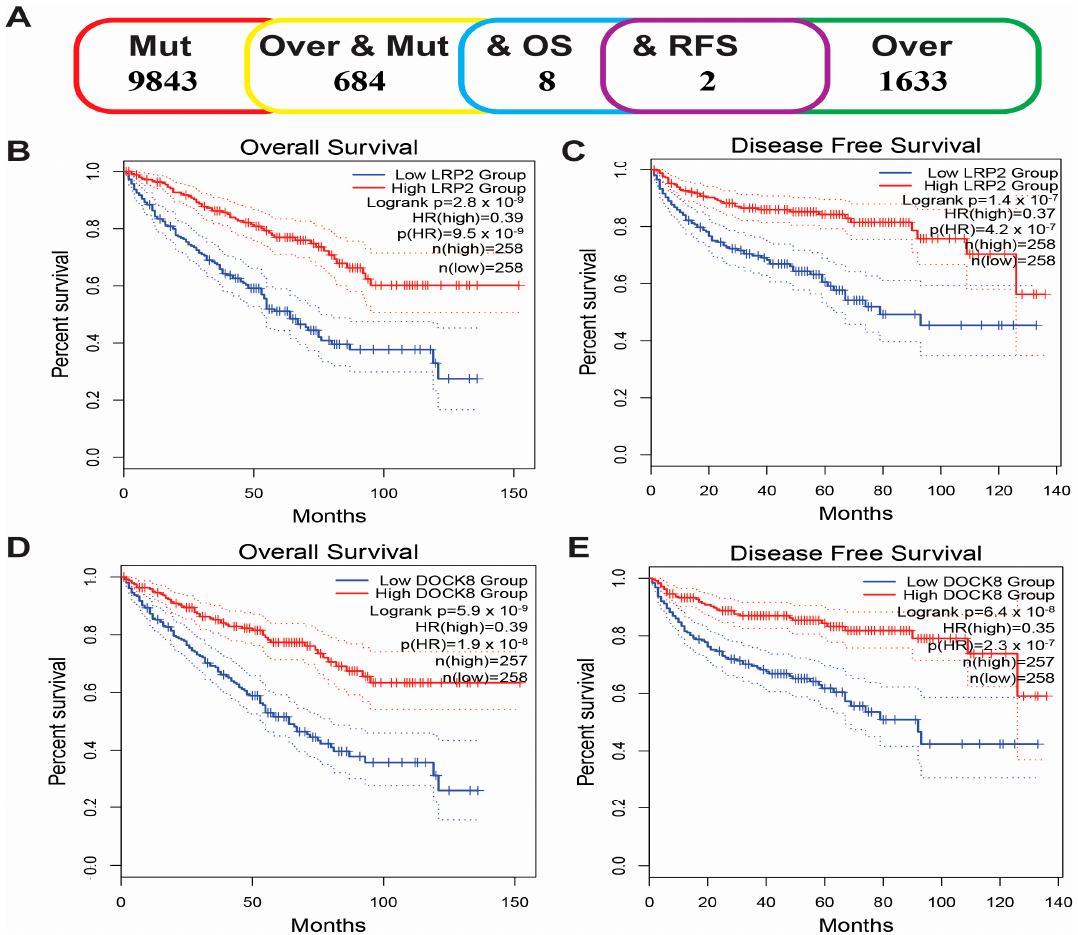
Figure 2. Identification of tumour antigens associated with KIRC prognosis. ( A ) Potential tumour antigens with overexpression and mutation are significantly associated with OS and RFS (2 candidate antigens). Kaplan–Meier curves showed that LRP2 expression was related to OS ( B ) and RFS ( C ) in KIRC patients. The Kaplan–Meier curve showed that the DOCK8 expression level was related to OS ( D ) and RFS ( E ) of KIRC patients. Kidney renal clear cell carcinoma (KIRC); Overall survival (OS); Relapse-free survival (RFS).